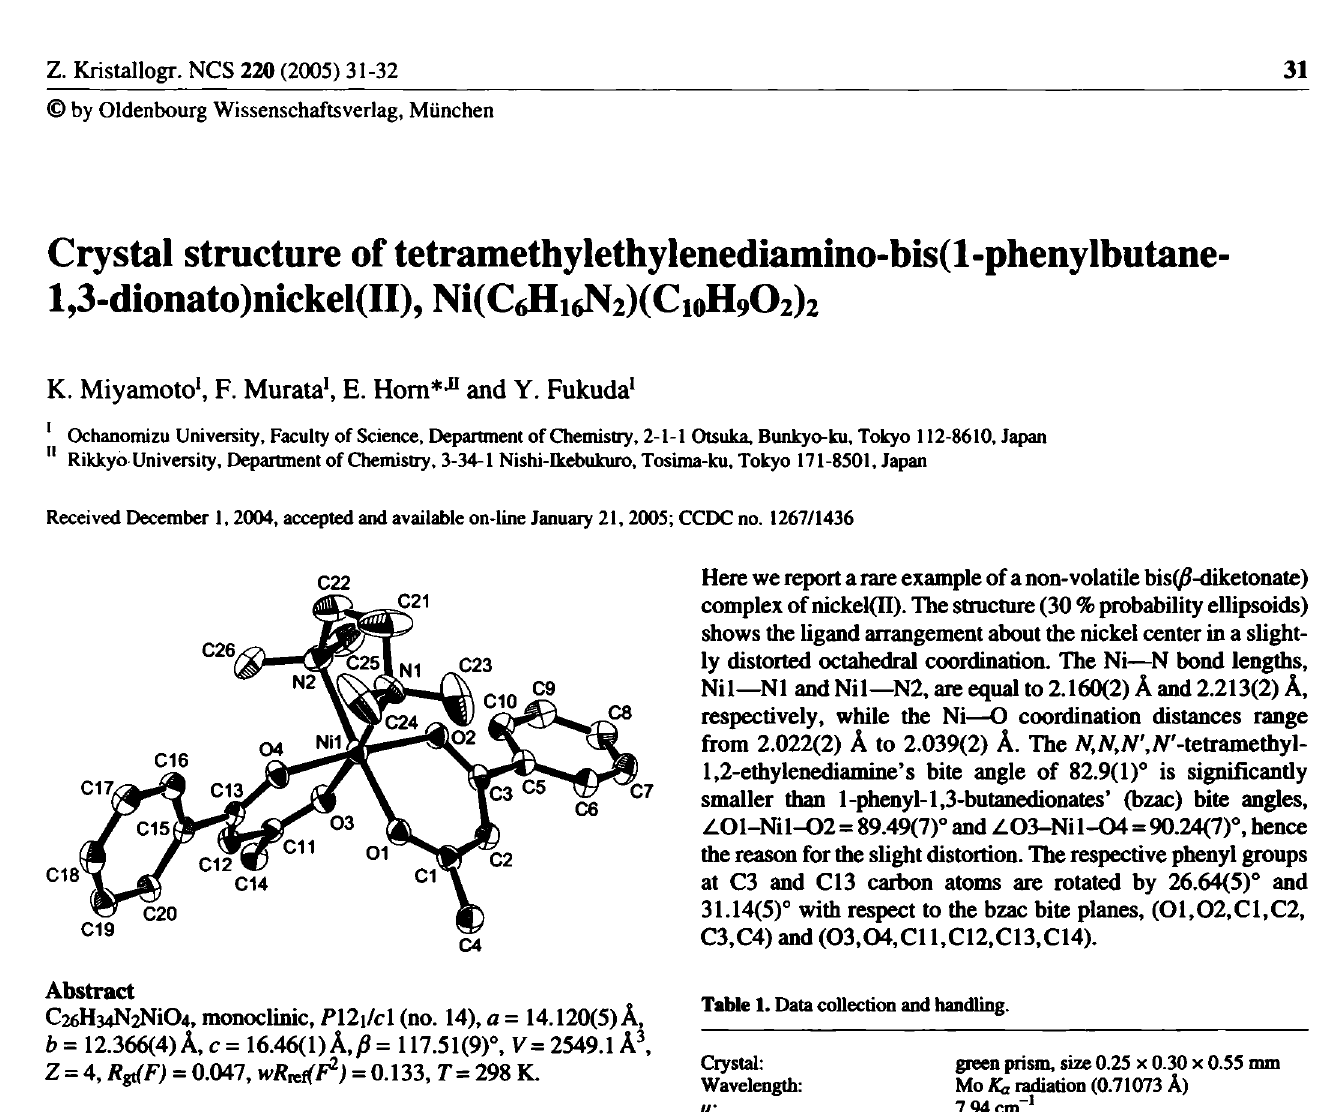
Table 2. Atomic coordinates and displacement parameters (in A 2